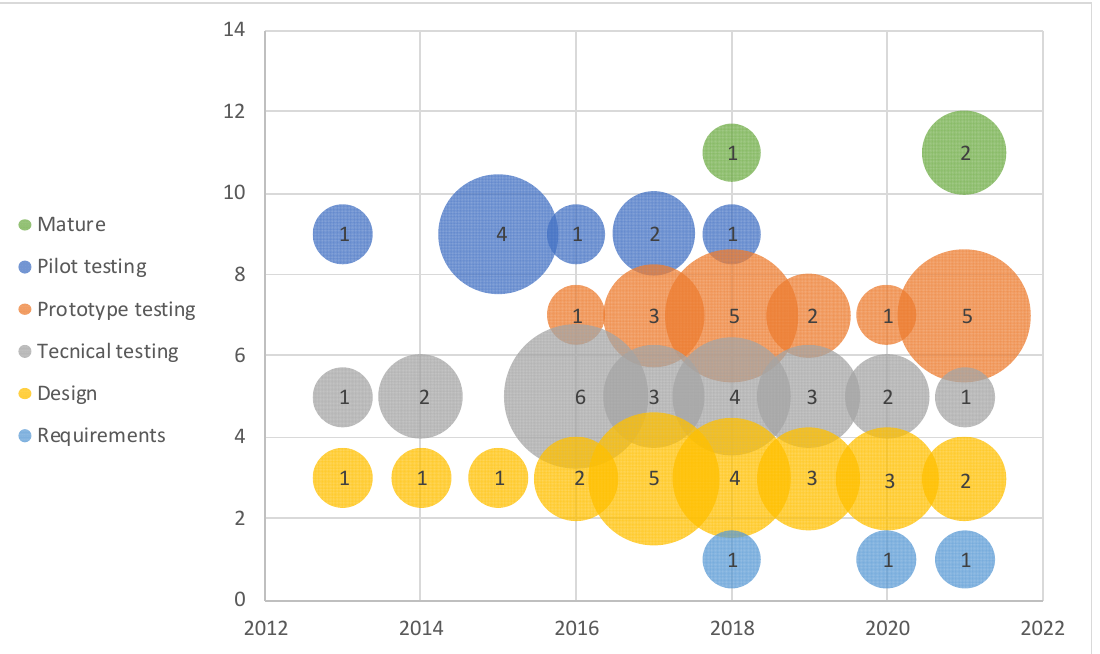
Figure 7. Number of studies by development stages over the years.